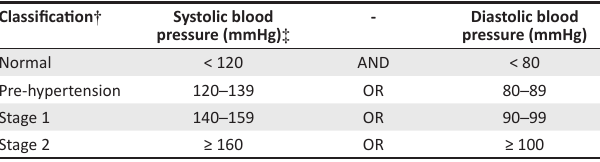
TABLE 2: Classification of hypertension.